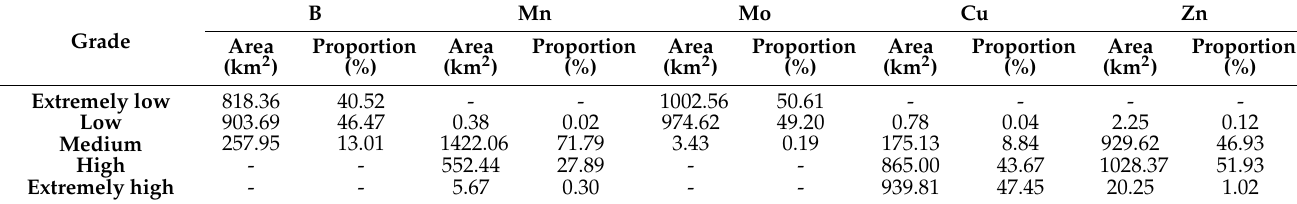
Table 4. The soil trace elements in different grades of soil area and